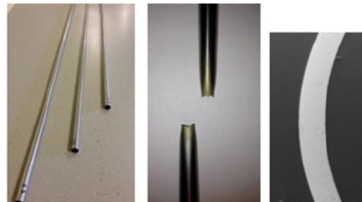
Fig. 2. Mo-alloy tubes with wall thickness of 0.2 mm and OD of 1.0